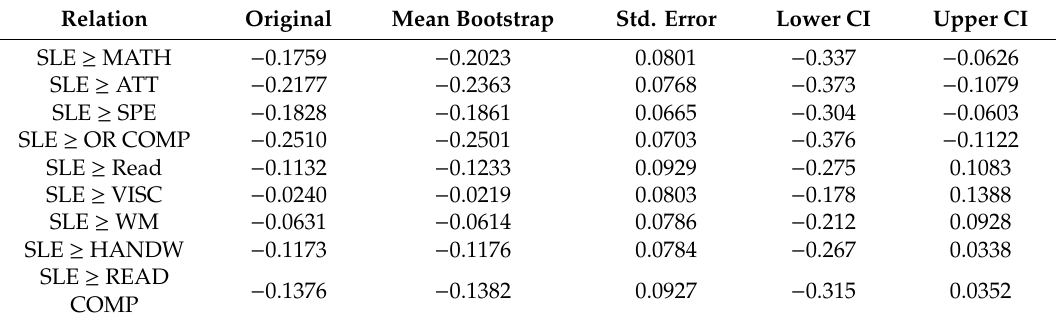
Table 5. Bootstrap validation of inner model paths coe ffi cient.